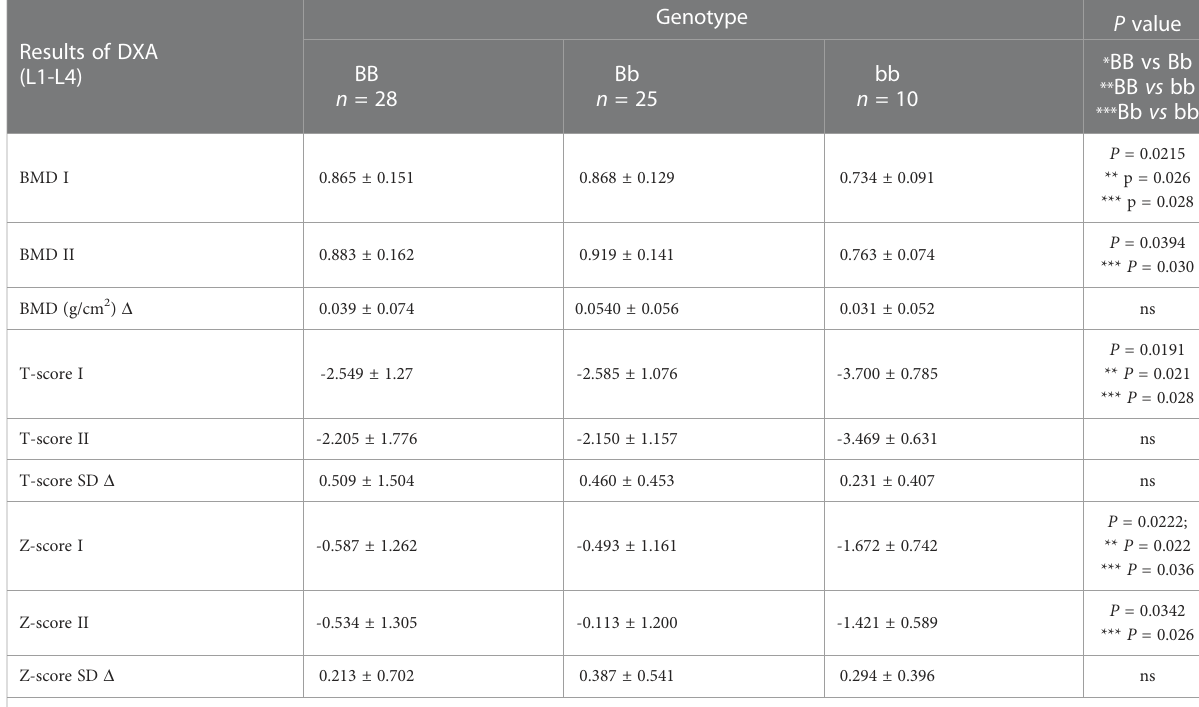
TABLE 2 Delta changes in DXA parameters for the VDR BsmI polymorphism in L1-L4.